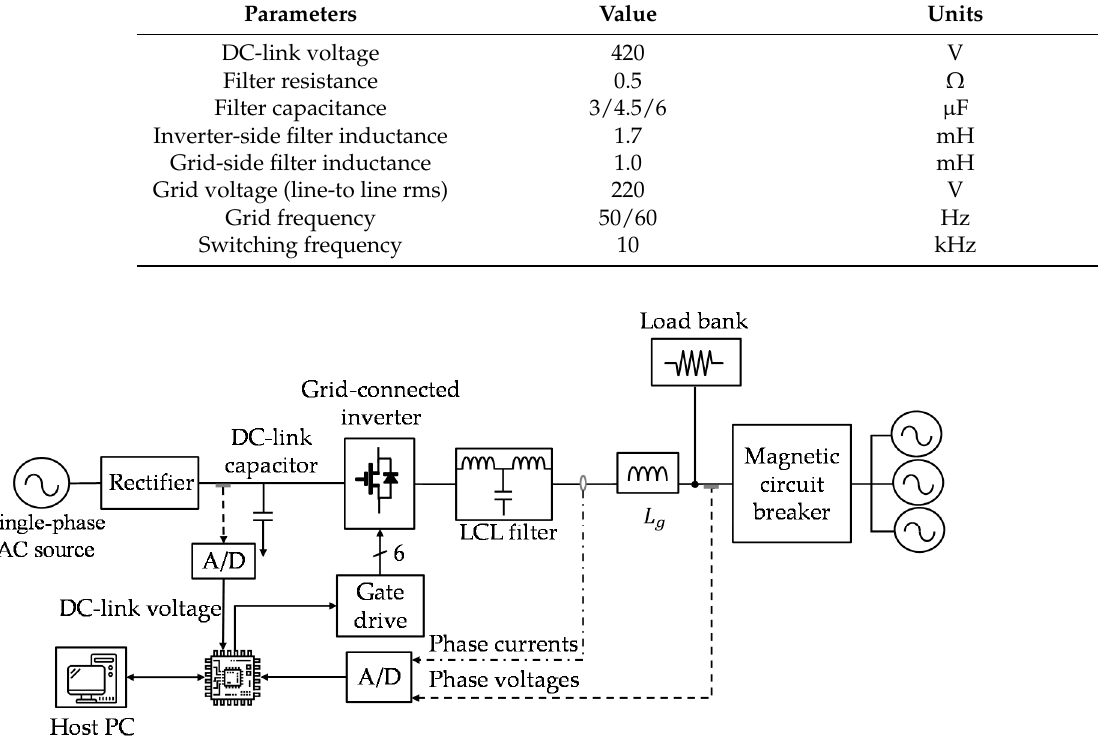
Table 2. Execution time of the proposed control scheme.